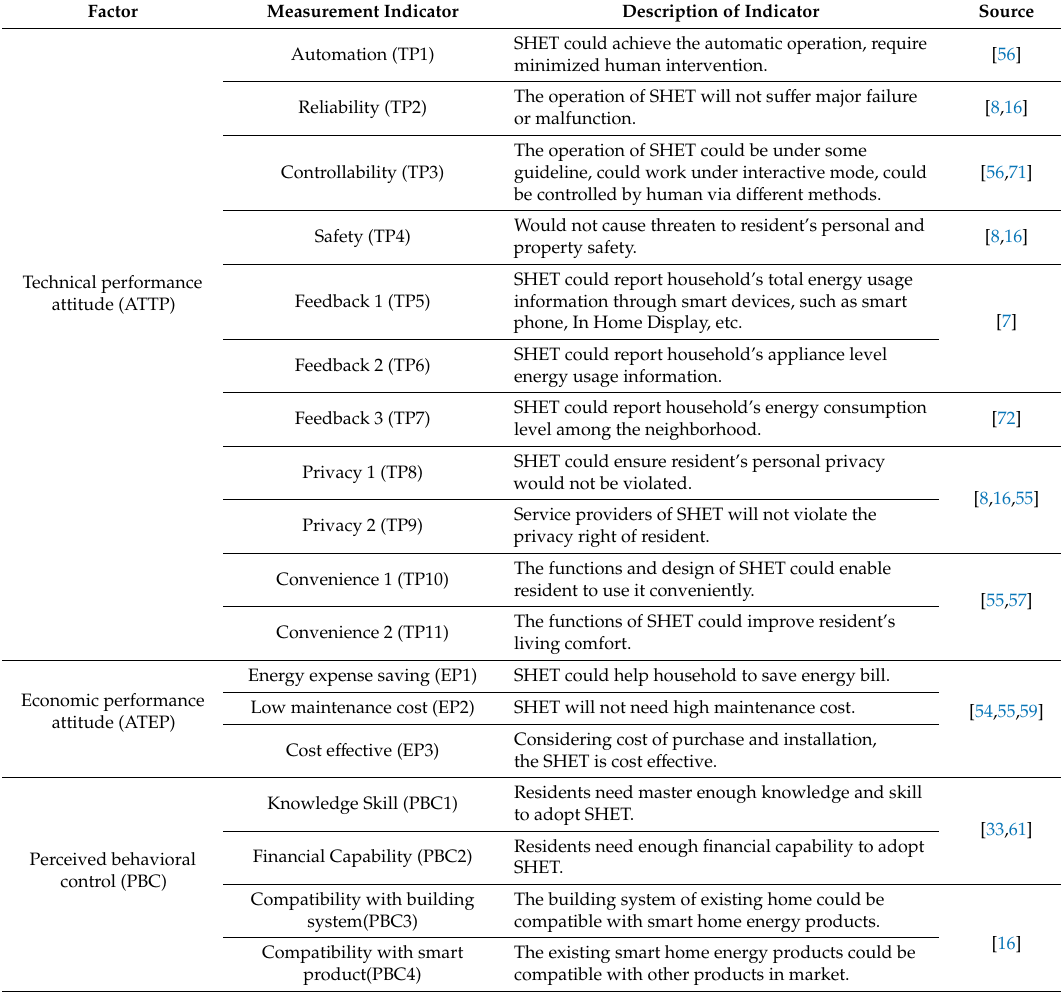
Table 2. Summary of influential factors and measurement